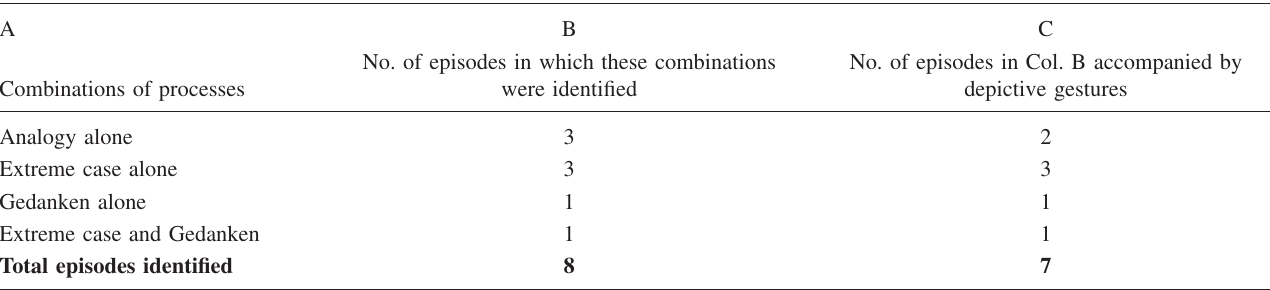
TABLE I. Evidence for student-generation of three nonformal scientific reasoning processes in Book on Table discussion (cid:1) approx. 45 min (cid:2) : Numbers of episodes. A B C Combinations of